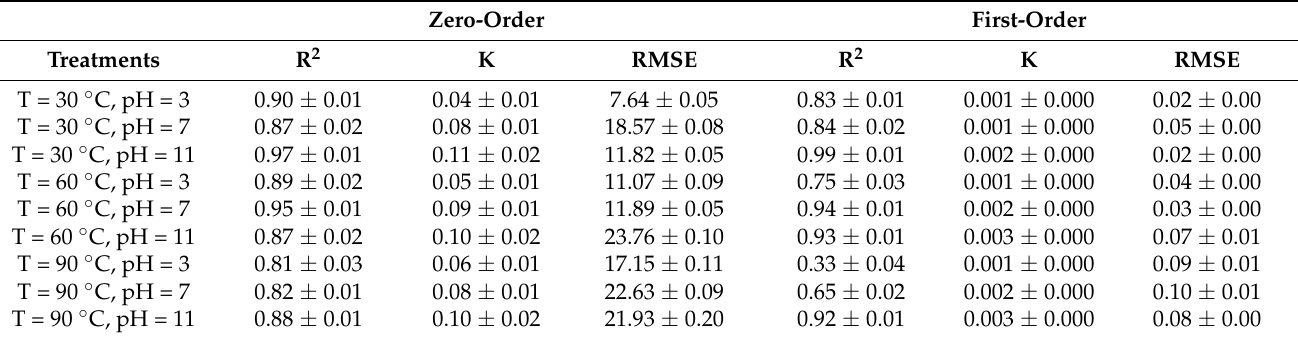
Table 1. Parameters of kinetics modeling for the release of orange peel oil from NC3 powder at different